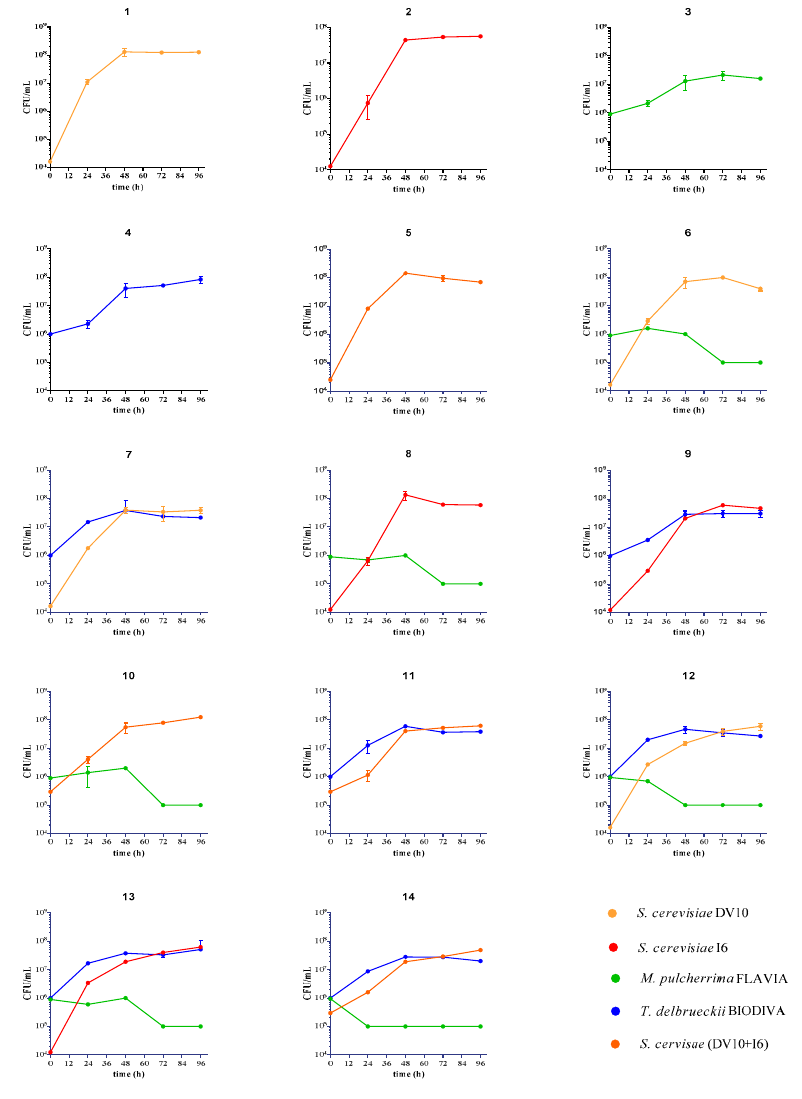
Figure 1. Viable cell count (cfu / mL) of di ff erent yeast single or mixed culture (Table 1) inoculated. S. cerevisiae (large white colonies) from non- Saccharomyces yeasts (green